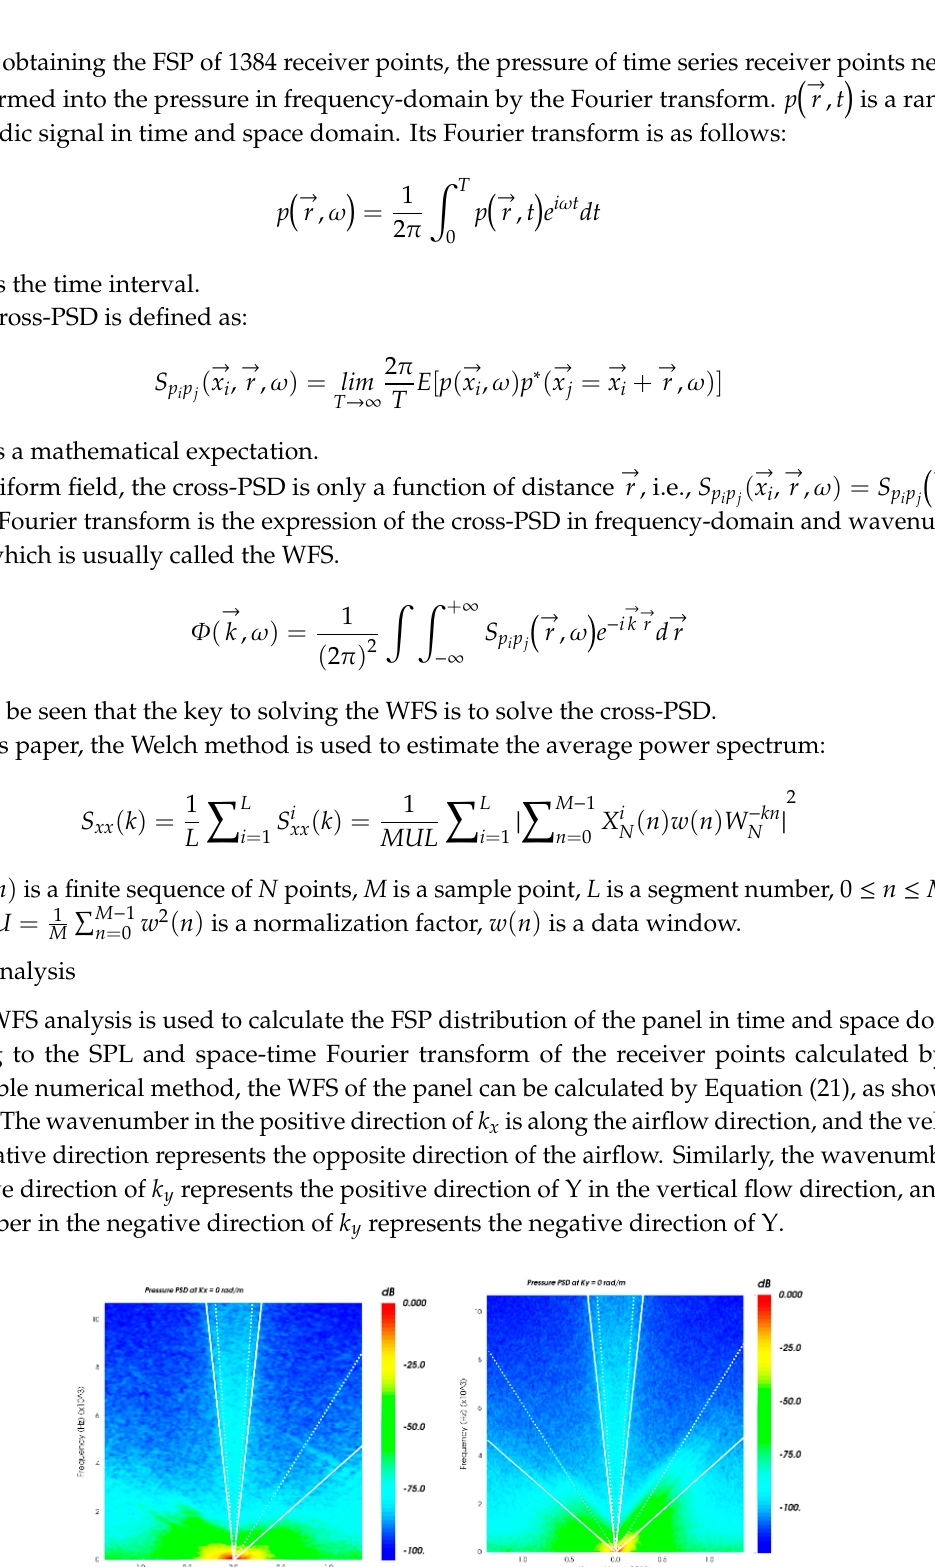
x = 0 rad/m; ( b ) k y = 0